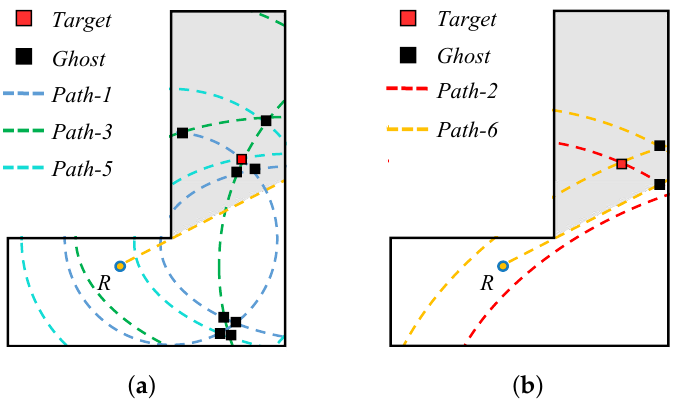
Figure 8. The distributions of target and ghosts in two views. ( a ) View 1. ( b ) View